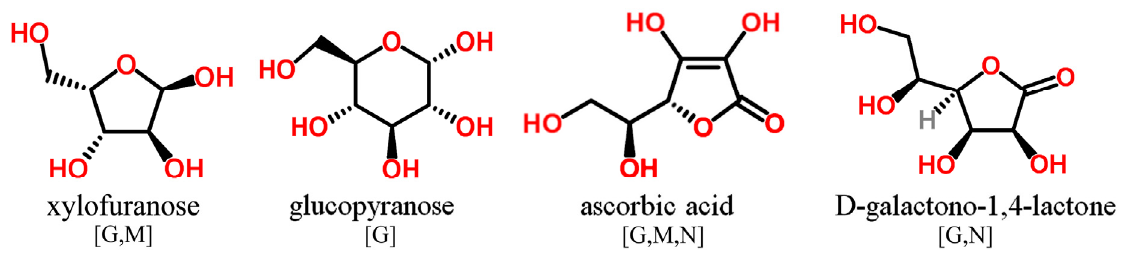
Figure 6. O -containing cyclic structures detectable in GC-MS profiling experiments. MS spectra included in publically available databases.